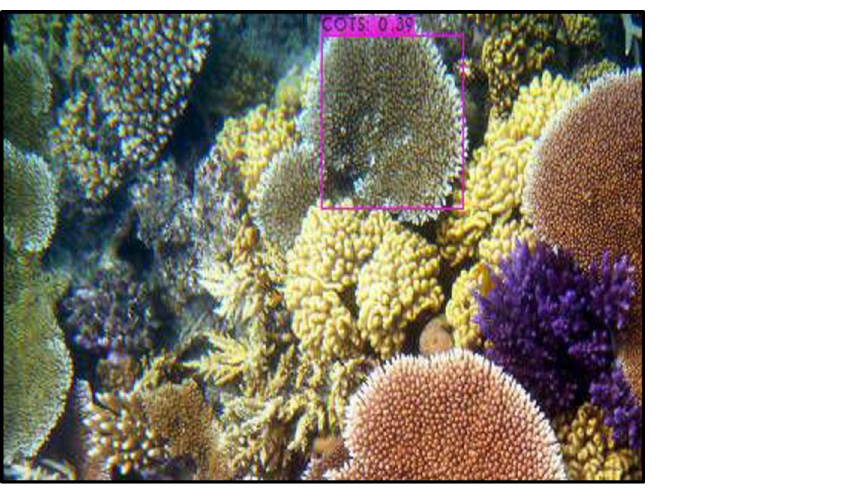
Fig 9. Non detection of starfish.